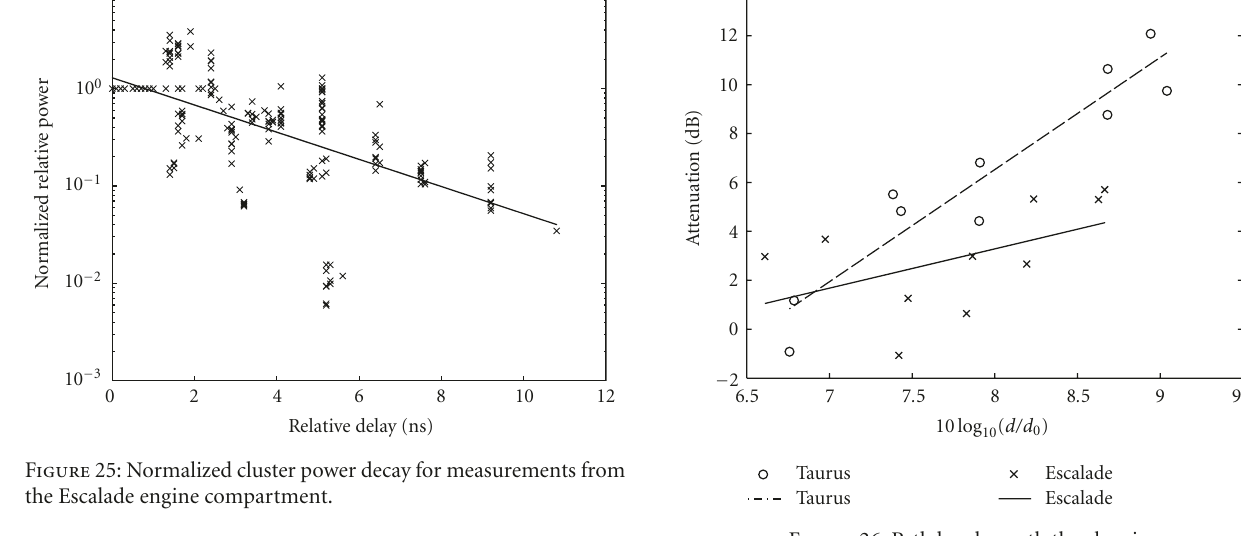
Figure 26: Path loss beneath the chassis.